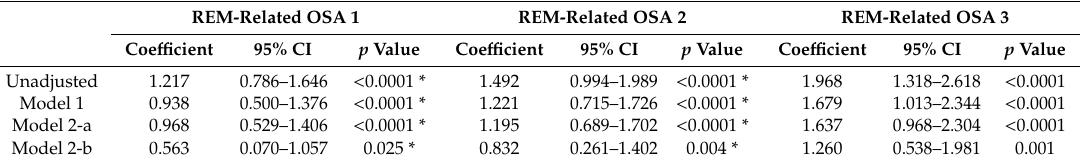
Table 2. Association between three di ff erent definitions of REM-related OSA and the Pittsburgh Sleep Quality Index.